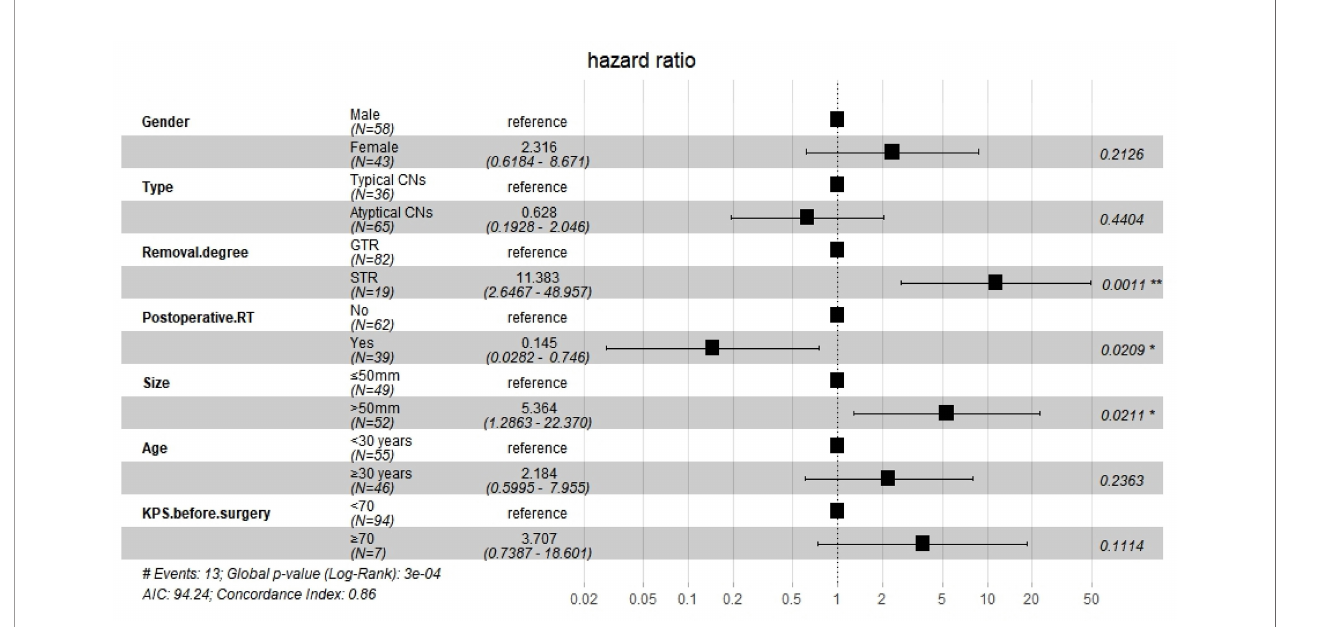
FIGURE 3 | Multivariate Cox regression analysis of factors affecting survival bene fi t of patients.